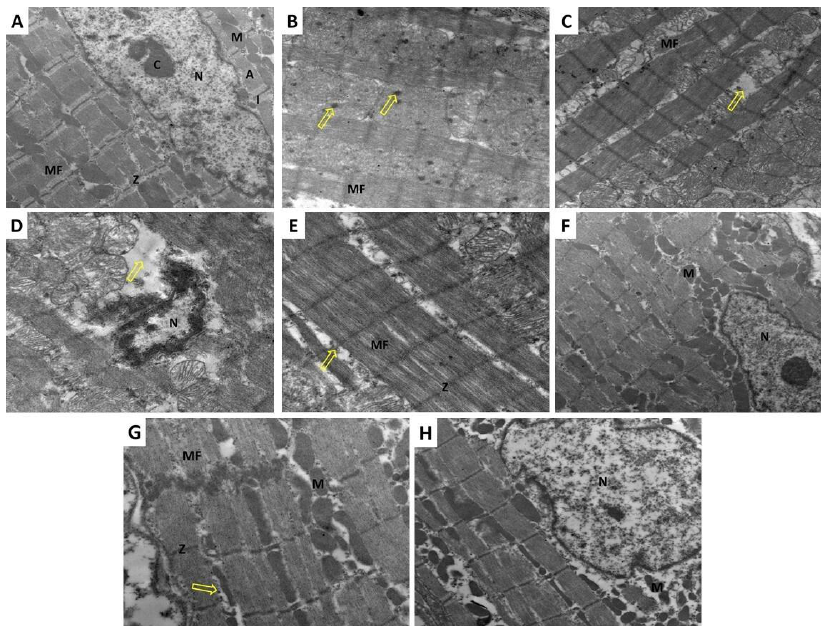
Figure 6. A transmission electron micrograph of a part of the cardiac muscle from the left ventricle of ( A ) The control group showing regular arrangement of the myofibrils (MF) in the sarcomeres between the Z-lines (Z) with arrangement of the mitochondria (M) in rows between them. The dark A-band appears in the middle (A) and the light I-band appears in the periphery (I) of the sarcomere. The nucleus is oval (N) with heterogenous chromatin (C) (Direct mag × 3000); ( B ) The control group showing regular arrangement of the myofibrils (MF). Also, scattered glycogen granules (arrow) appear between the myofibrils and in association with mitochondria are seen (Direct mag × 5000); ( C ) Doxorubicin-treated group showing disruption of the normal architecture of the cardiac muscles. The cardiac myofibrils (MF) are fragmented and widely separated. The mitochondria are of different sizes and depletion of mitochondria in some areas can be seen (arrow) (Direct mag × 3000); ( D ) Doxorubicin-treated group showing shrunken nucleus (N) with irregular outlines and peripheral chromatin condensation. The perinuclear zone shows few mitochondria (arrow) (Direct mag × 5000); ( E ) Doxorubicin + fraxetin small dose group showing apparent restoration of the normal architecture of the cardiac myscles. The myofibrils (MF) are regularly arranged within the sarcomeres between the Z-lines (Z). The mitochondria (M) are normally arranged in between. Some thinning out of the myofibrils and separation are seen (arrow) (Direct mag × 5000); ( F ) Doxorubicin + fraxetin small dose group showing indentation and mild peripheral chromatin condensation of the nucleus (N). Apparently normal mitochondria (M) are seen in the peri nuclear zone (Direct mag × 3000); ( G ) Doxorubicin + fraxetin large dose group showing regular arrangement of the myofibrils (MF) of the cardiac muscles in the sarcomeres between the Z-lines (Z) with arrangement of the mitochondria in rows between them (M). Scattered glycogen granules in association with the mitochondria are seen (arrow) (Direct mag × 5000); ( H ) Doxorubicin + fraxetin large dose group showing an oval nucleus (N), which appears normal in size with regular nuclear envelope and abundant perinuclear mitochondria (M) (Direct mag ×